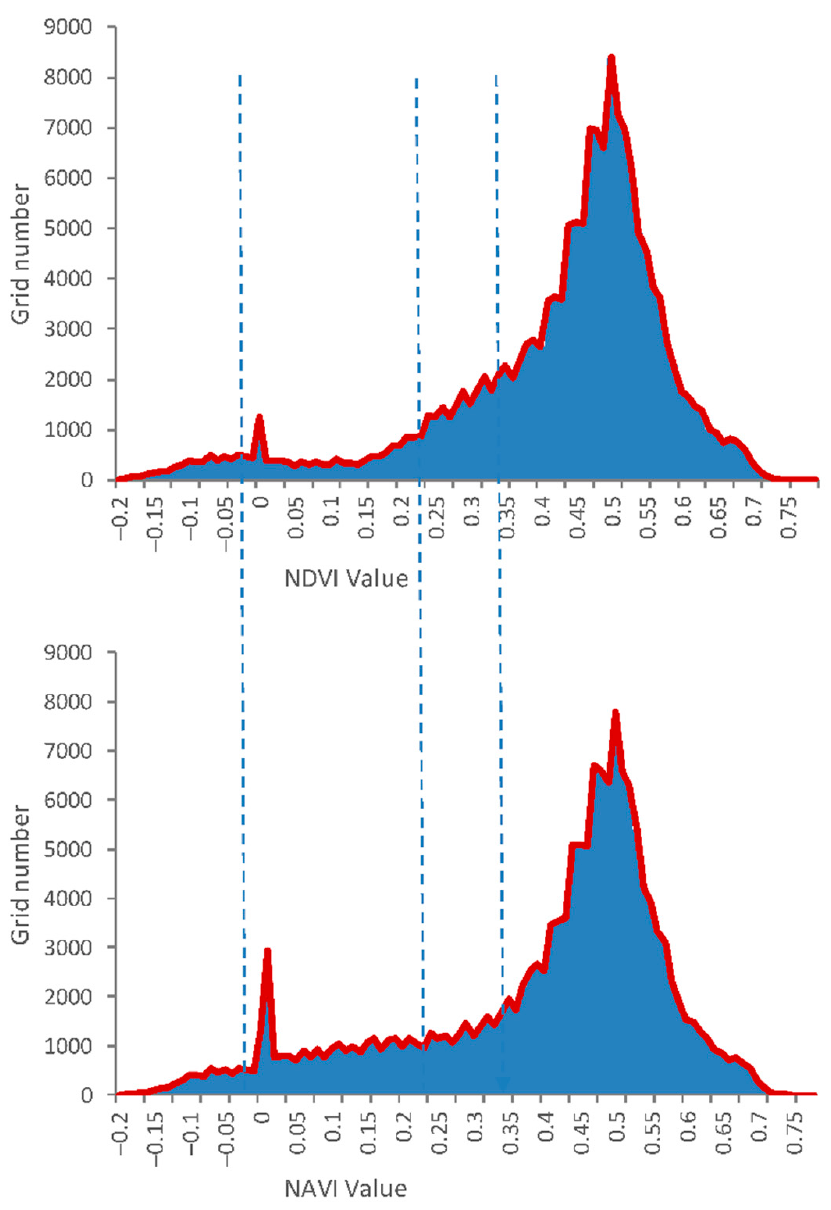
Figure 3. Histogram of NDVI and NAVI.